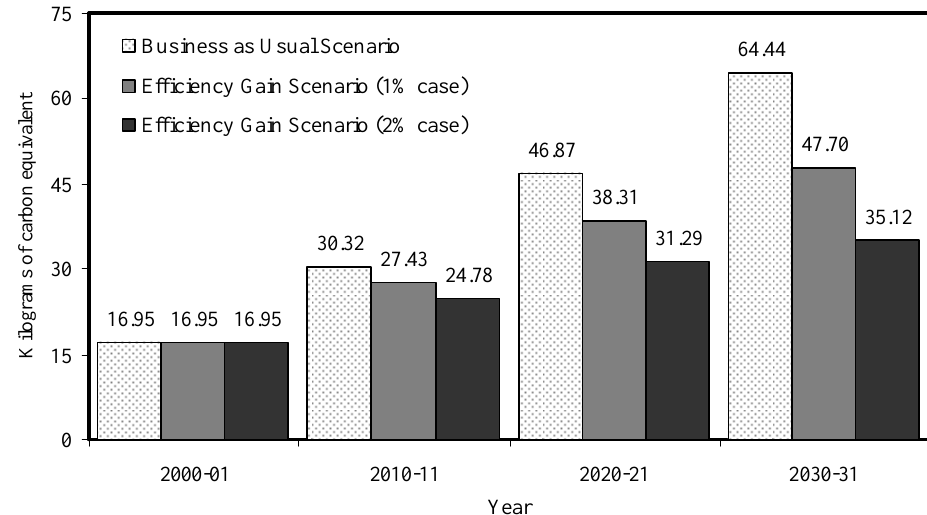
Figure 5. Per capita CO emission from road passenger transport in 2